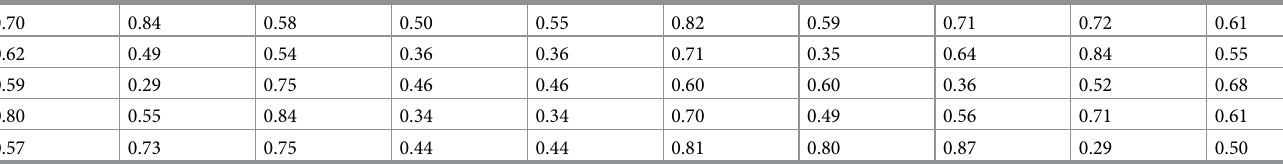
Table 3. Relief time (in hours) for 50 arthritic patients.